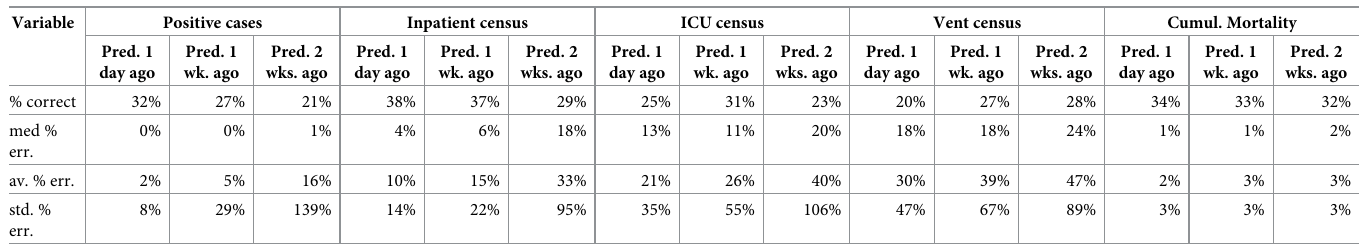
Table 4. Accuracy of the NS COVID-19 model, Mar. 10, 2020–May 24,